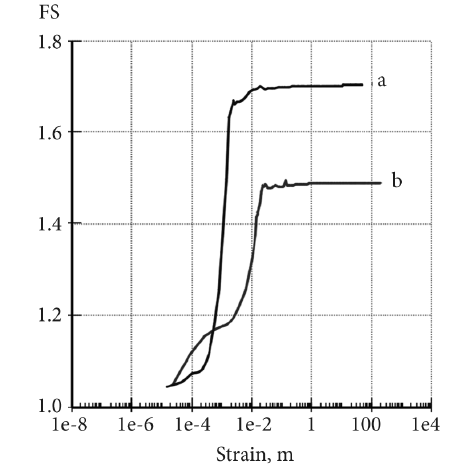
Figure 8. Slope Stability factors for different type of soil (a, Clayey Loam; b,